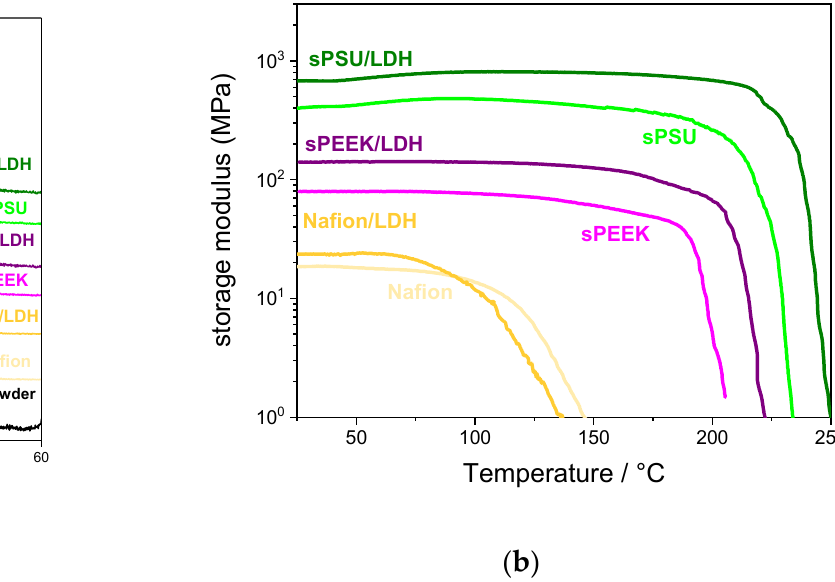
Figure 3. ( a ) XRD patterns and ( b ) DMA thermograms for the Nafion-based, sPEEK-based, and sPSU-based membranes.